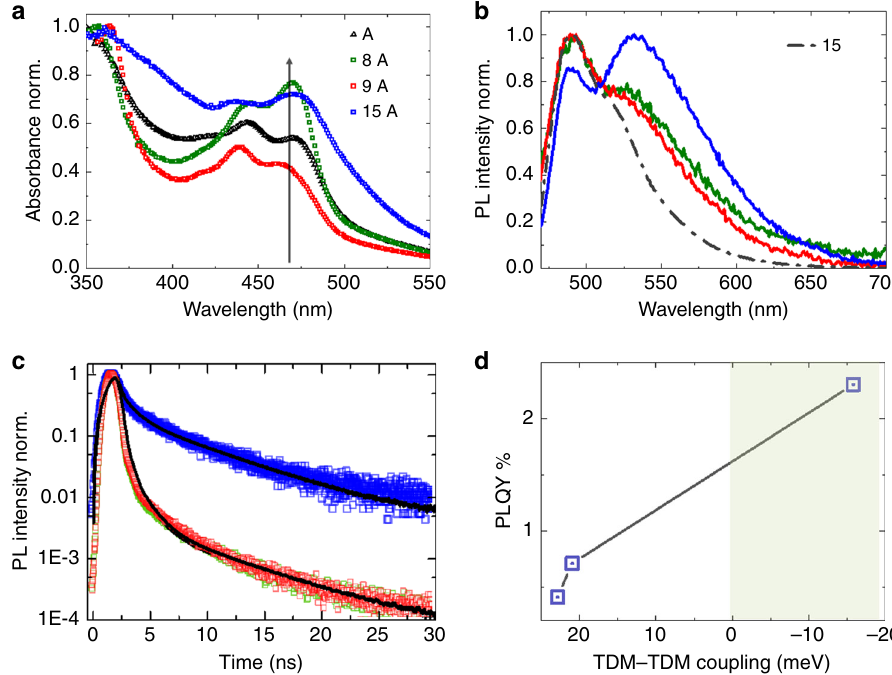
Fig. 4 Photophysical properties of the SURMOFs. a Absorption spectra of 8A, 9A, and 15A illustrating the different vibronic ratios compared to that of the A, the black arrow indicates the position of the A (0 – 0) transition in solvated NDI(OEt) 2 chromophores irrespective of the different R substituents. b PL spectra of 8A, 9A, and 15A and iPr-NDI(OEt) 2 (15) in ethanol (20 μ M) upon excitation at 450 nm, recorded at room temperature, with the color code being the same as in panel a . c PL decay of 8A, 9A, and 15A. Color code is same as in panel a , and the black lines correspond to the exponential fi ts. d Plot of experimentally obtained PLQY vs predicted TDM – TDM coupling (as in Fig. 1b); the green marked area indicates the J-type